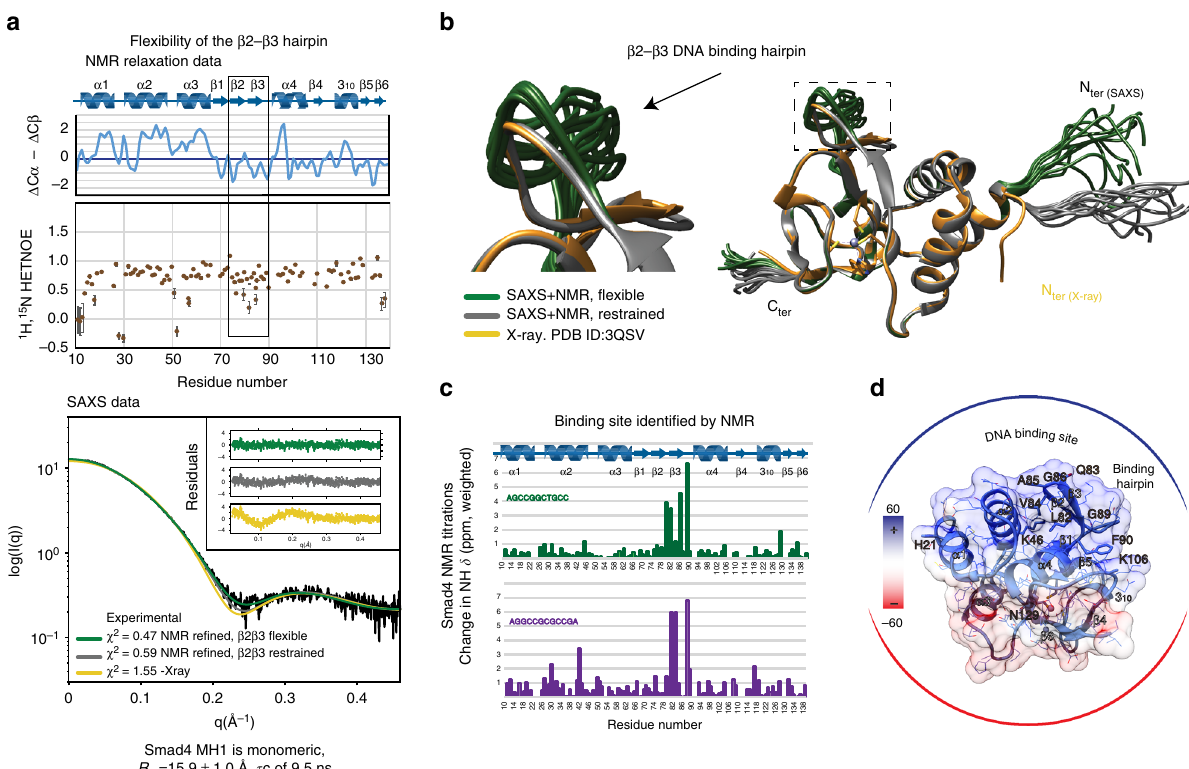
Fig. 3 Structure and GC binding site of Smad4 MH1 domain in solution. a Heteronuclear NOEs values for all non-overlapped amides (shown as brown circles). Elements of secondary structure of Smad4 MH1 domain (10 – 140 residues) characterized using 13 C chemical shift values (in blue) and NOE patterns are shown on top of the heteronuclear NOEs. Values of the β 2 – β 3 DNA-binding hairpin are highlighted within a box, to indicate the fl exibility of these residues in the absence of DNA. The SAXS scattering curves corresponding to a merged curve generated from data at several protein concentrations (0.5 – 4.2 mg mL − 1 ) are shown below. χ 2 values of the different fi ttings are indicated. b Superimposition of the 10 best structures determined using the solution scattering curves SAXS re fi ned with the NMR chemical shift values obtained in solution. c Identi fi cation of residues involved in DNA binding using NMR titrations. Chemical shift differences are shown as bars (green: AGCCGGCTGCC and blue: AGGCCGCGCCGA, respectively) using a 0.2 weighting of 15 N with respect to 1 H. The HSQC data displaying the chemical shifts induced upon binding are shown in Supplementary Fig. 3. d Residues affected upon DNA binding are displayed on the surface of the solution structure of Smad4 MH1 domain shown in b . The electrostatic charge distribution was